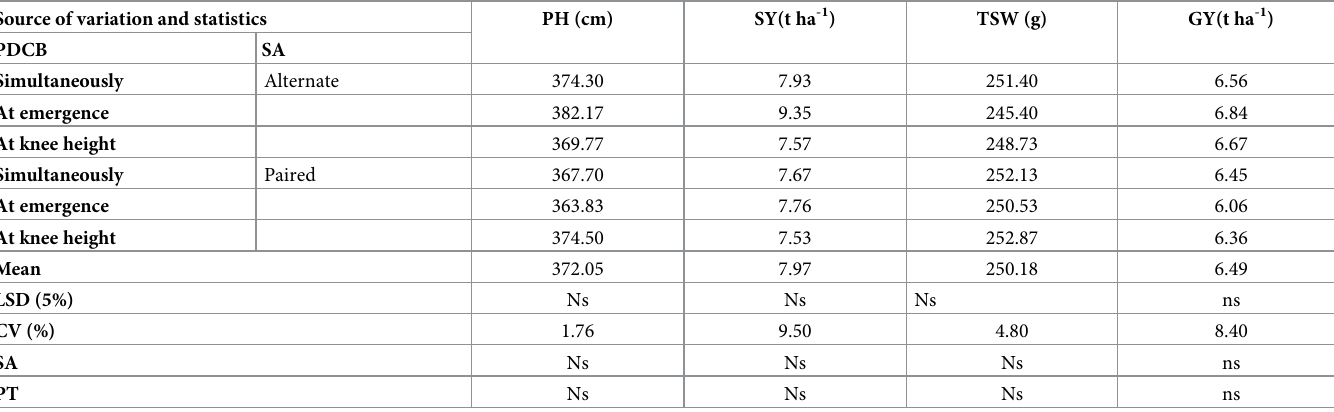
a Data was combined over years (2014 and 2016). PDCB = Planting date of common bean with maize in a mixture; SA = spatial arrangements of the component crops; PH = plant height (cm); SY = stover yield (t ha -1 ); TSW = thousand seed weight (gram); GY = grain yield (t ha -1 ); SA = spatial arrangement; PT = planting time of common bean; ns is non-significant at 0.05 probability